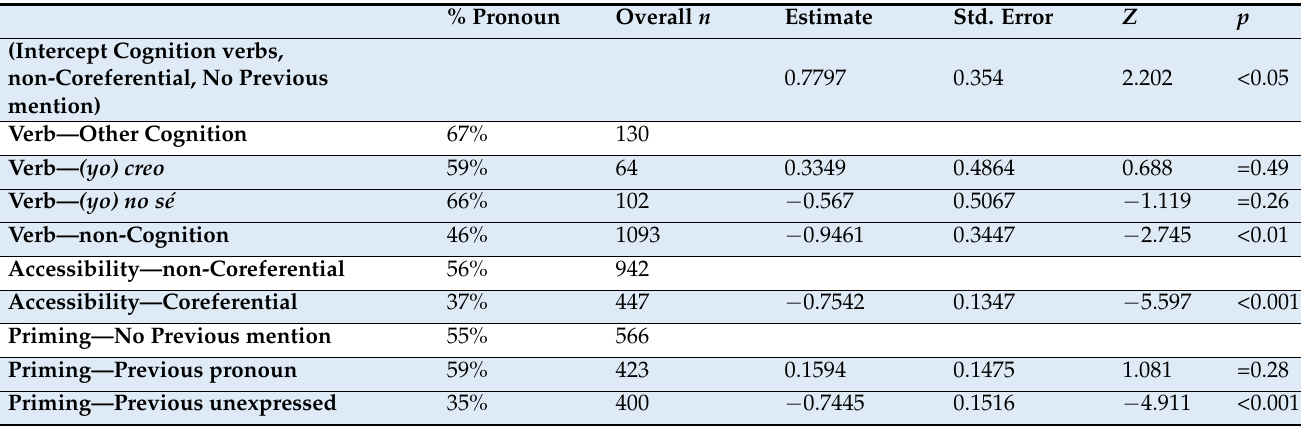
Table 2. Generalized linear (mixed) model predicting an expressed subject with 1sg verbs. % Pronoun Overall n Estimate Std. Error Z